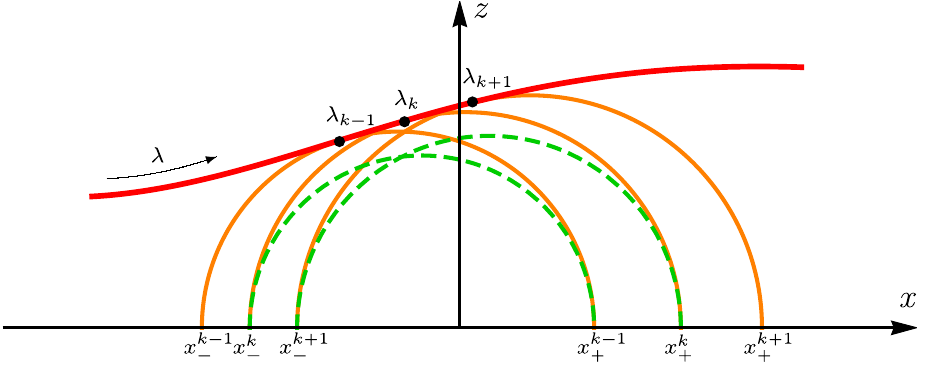
ment entropy of the intersections of I k with their immediate neigh- bours, S ( I k ∩ I k + 1 ) and S ( I k − 1 ∩ I k ) (depicted in dashed green). A one- parameter generalization of the discrete version of differential entropy is given by (125). It includes the two original versions, and differs in general by a boundary